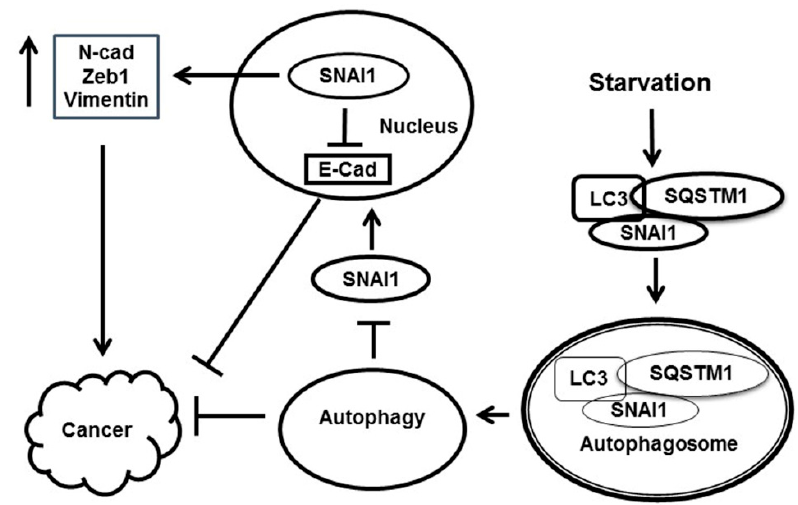
Figure 7. Schematic representation of autophagy-dependent SNAI1 degradation during cancer progression. Starvation-induced autophagy leads to the degradation of SNAI1 via the incorporation of LC3 – SQSTM1 – SNAI1 complexes into autophagosomes. Consequently, the low levels of nuclear SNAI1 cause a decrease in the levels of EMT-related proteins (N-cadherin, Zeb1, and vimentin) and an increase in E-cadherin through transcriptional deactivation. Thus, the induction of autophagy inhibits cancer progression.